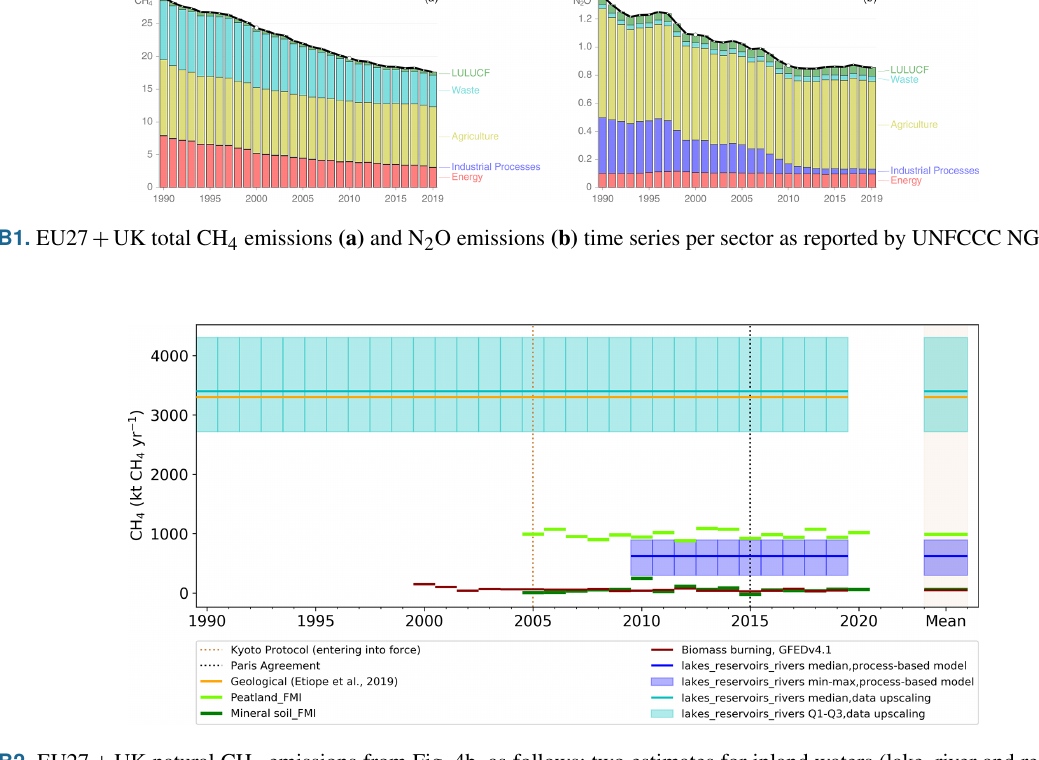
Figure B2. EU27 + UK natural CH 4 emissions from Fig. 4b, as follows: two estimates for inland waters (lake, river and reservoir process- based models, blue, and upscaled emissions, cyan), peatlands and mineral soils (from JSBACH–HIMMELI, light green and dark green), geological emissions (orange), and biomass burning (from GFEDv4.1,